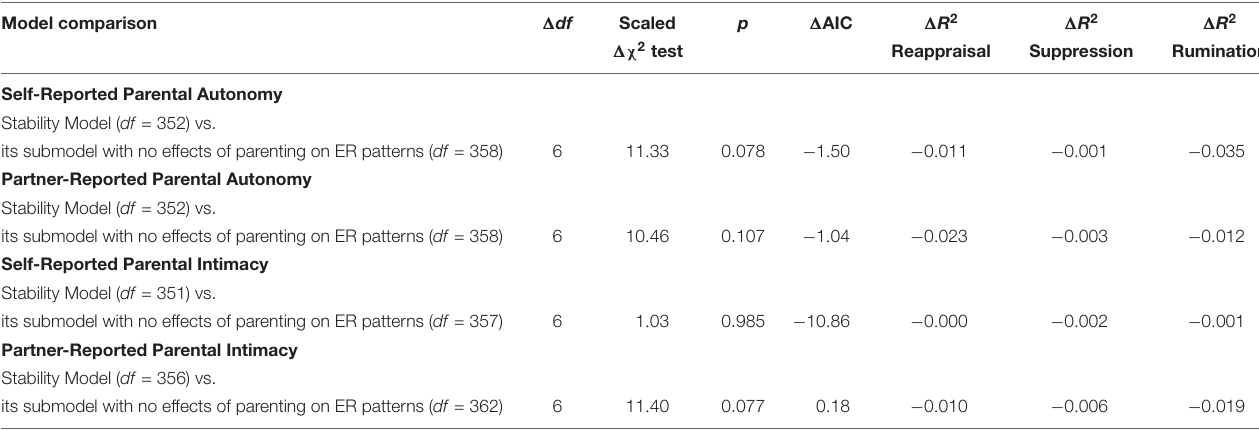
TABLE 2 | Comparisons of Stability Model and its submodel with no effects of parenting in late adolescence on adolescents’ emotion regulation patterns. Model comparison